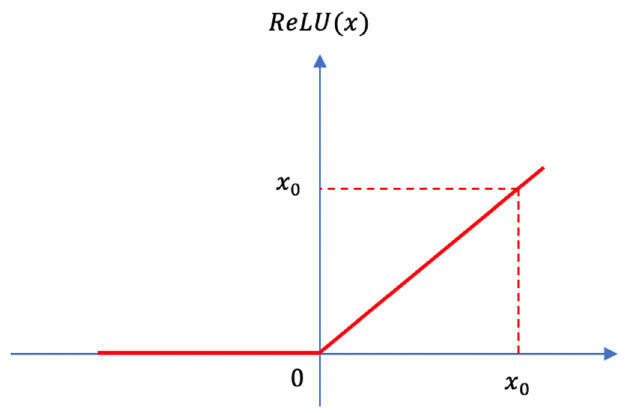
Figure 14. ReLU Figure 14. ReLU function.